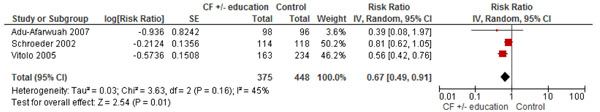
Forest Plot for the effect of complementary feeding with or without education: Acute respiratory infections